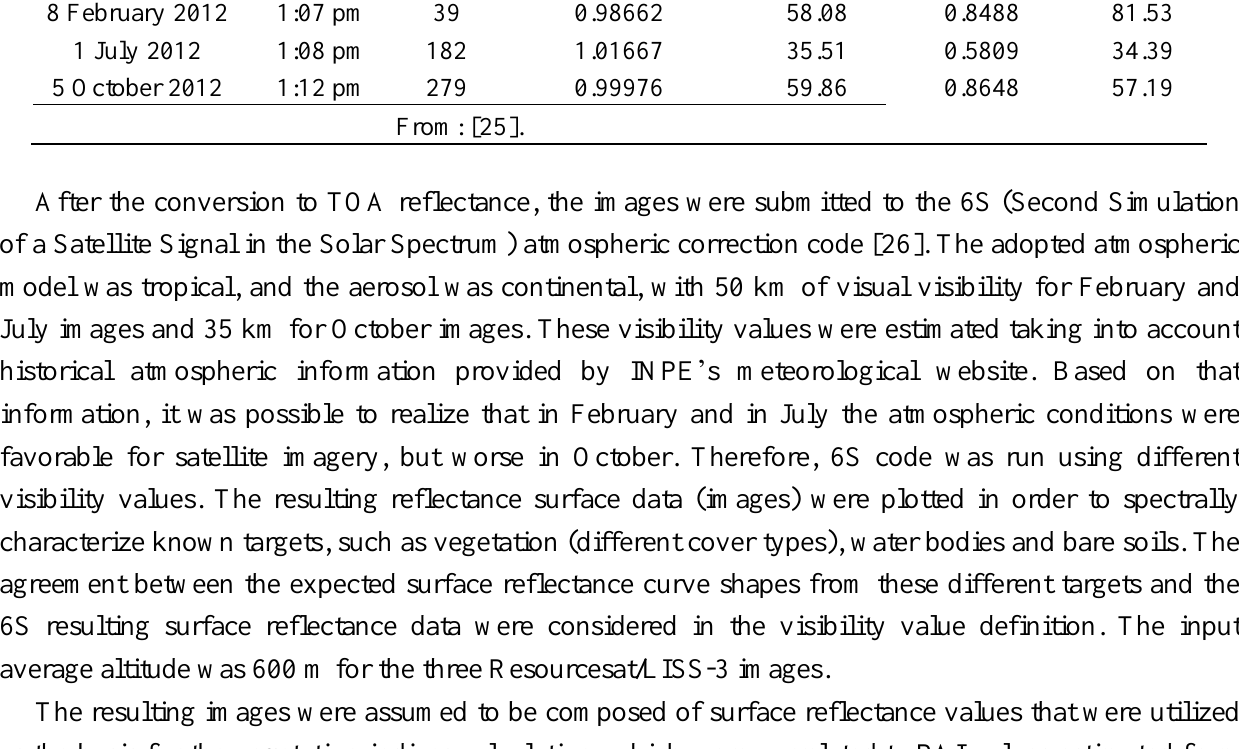
Table 2. Resourcesat/LISS-3 data and solar positioning at the image acquisition dates.